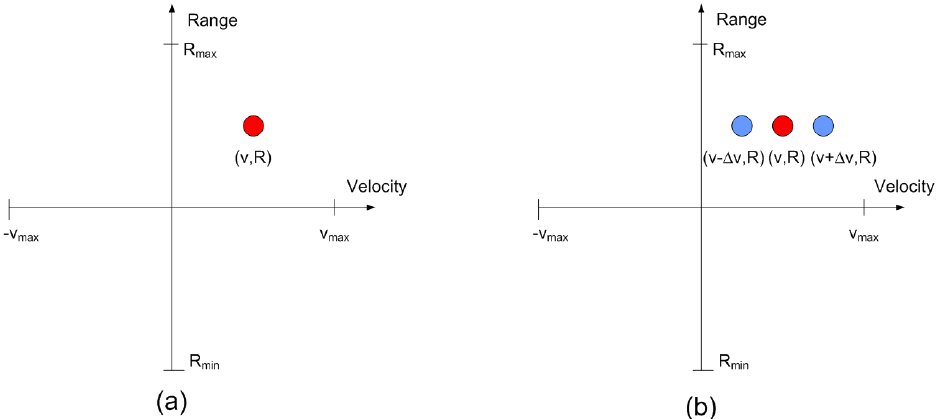
Figure 6. Transponder detection based on its spectral signature: ( a ) Target or transponder with the modulation off, and ( b ) modulated transponder with the modulation